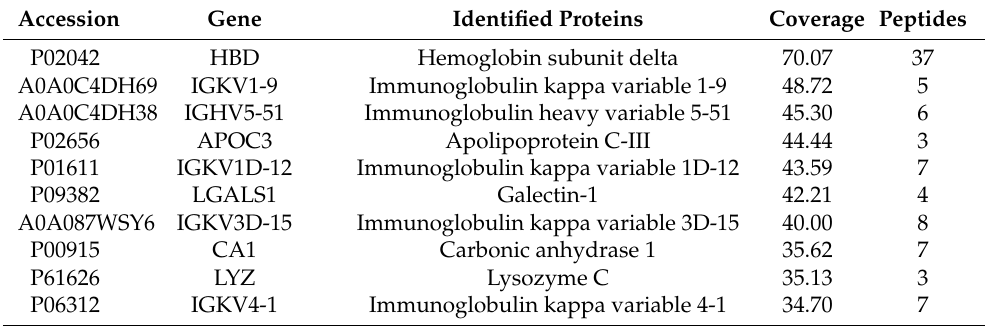
Table 1. Proteins interacting with ENO1 in postoperative lymphatic drainage (PLD) from patients with oral squamous cell carcinoma (OSCC) ( n =